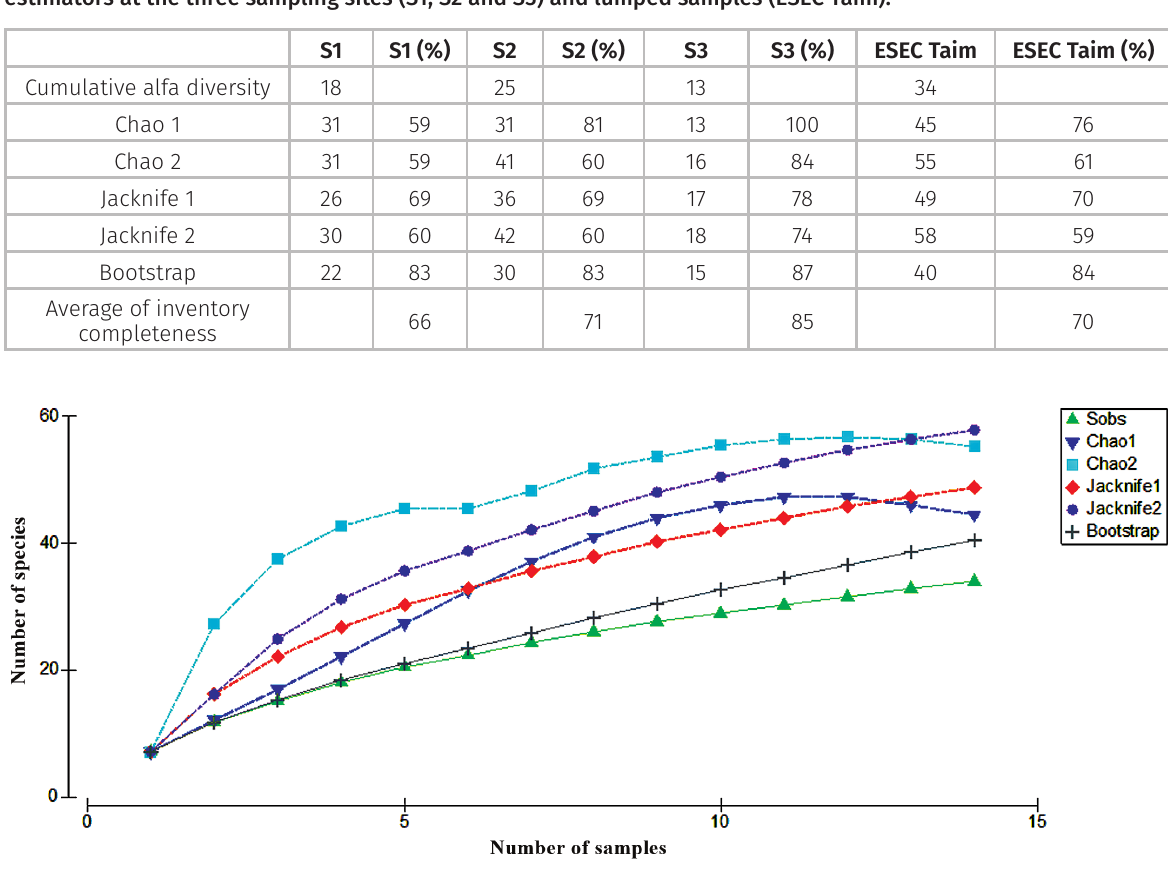
Figure 4. Completeness of the inventory of the species determined by different richness estimators (using lumped samples) at the Taim nature reserve (ESEC Taim) (Sobs: observed